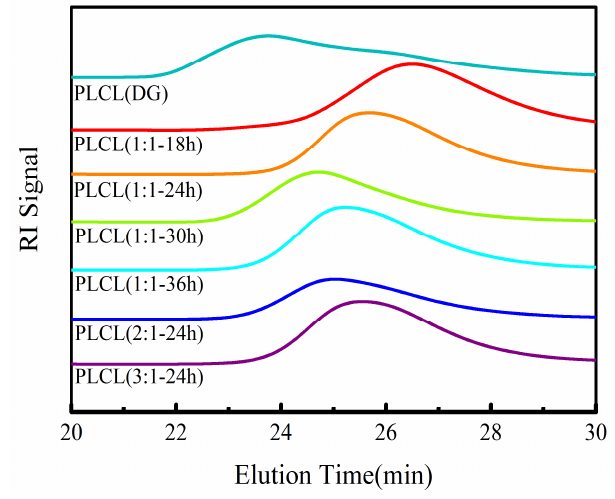
Figure 4. Gel permeation chromatography (GPC) curves of PLCL copolymers.